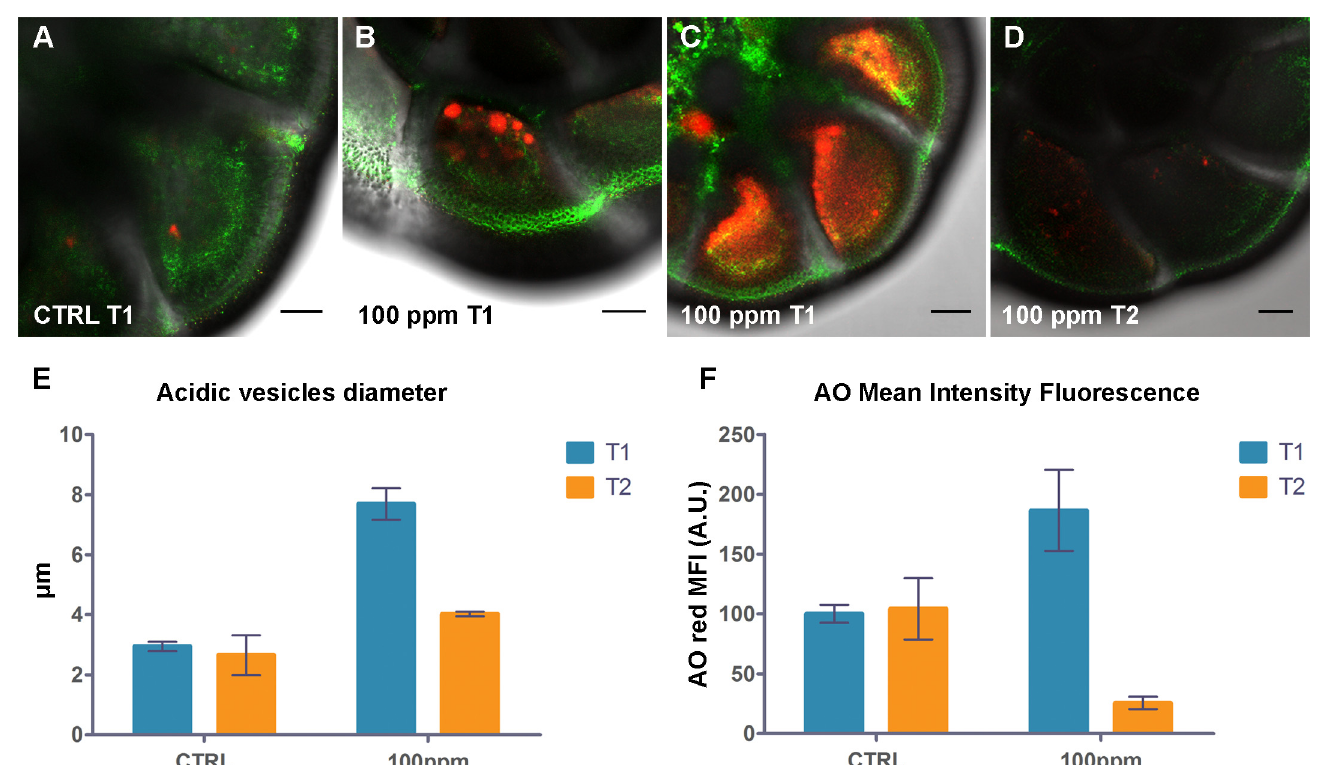
Fig 2. Effect of Hg exposure on acidic compartmentalization of A . parkinsoniana labeled with AO. Epifluorescence micrographs of single optical sections showing overlay of AO green and red fluorescence for (A) T1-control, (B,C) T1-100 ppm, and (D) T2-100 ppm, Bars: 20 μ m. (E) Histogram of maximum dimension (diameter) of acidic vesicles. (F) Histogram of red Mean Fluorescence Intensity (MFI) expressed in arbitrary units (A.U.) for control and 100 ppm at both T1 and T2. Error bars indicate ± standard error of the mean.